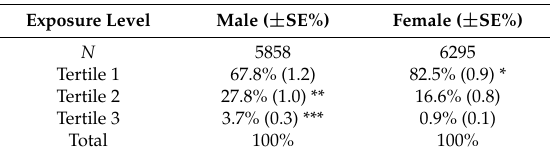
Table 3. Gender and Tertiles of Exposure.